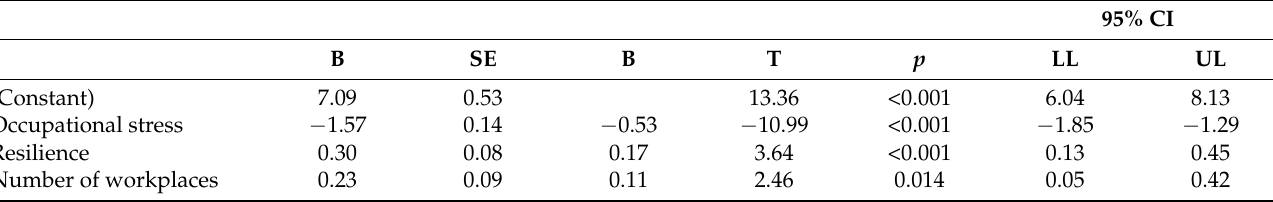
Table 4. Multiple linear regression model explaining job